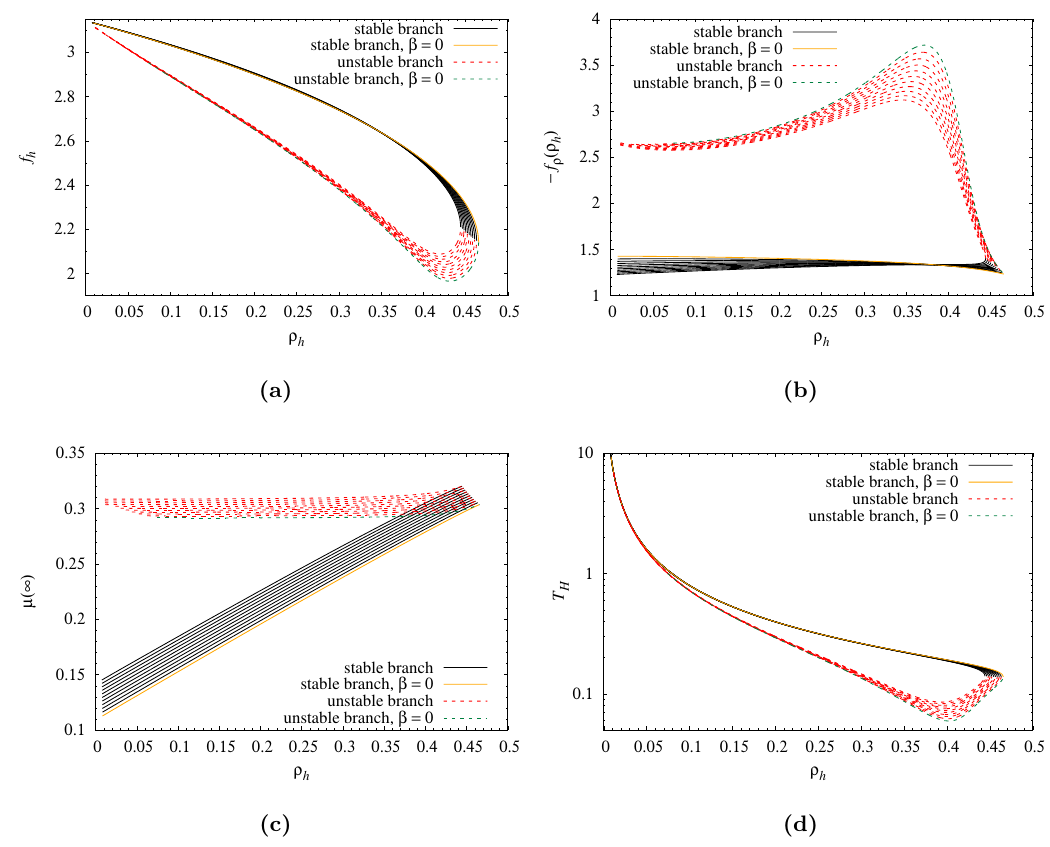
Figure 7 . Stable (black solid lines) and unstable (red dashed lines) branches of solutions in the 2 + 4 + 8 model with (cid:13) = 1 : (a) the value of the pro(cid:12)le function at the horizon, f h ; (b) the 3 derivative of the pro(cid:12)le function at the horizon, f (cid:26) ( (cid:26) h ); (c) the ADM mass, (cid:22) ( 1 ); (d) the Hawking temperature T H , all as functions of the size of the black hole, i.e. the horizon radius, (cid:26) h . In (a) and (d) (cid:12) = 1 for the innermost branch (both stable and unstable), and decreases to (cid:12) = 0 for the outermost branch. In (b) (cid:12) = 1 starts as the lowest branch and crosses over to the higher branch as (cid:26) h is increased, for the stable branch. For the unstable branch, (cid:12) = 1 corresponds to the lowest branch. In (c) the topmost branches (both stable and unstable) correspond to (cid:12) = 1 and the branches move downward as (cid:12) ! 0. The stable and unstable (cid:12) = 0 branches are shown in orange and dark green colors,